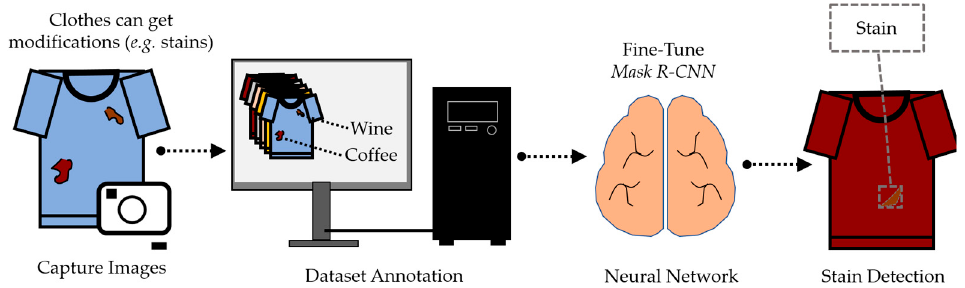
Figure 4. Workflow methodology for stain